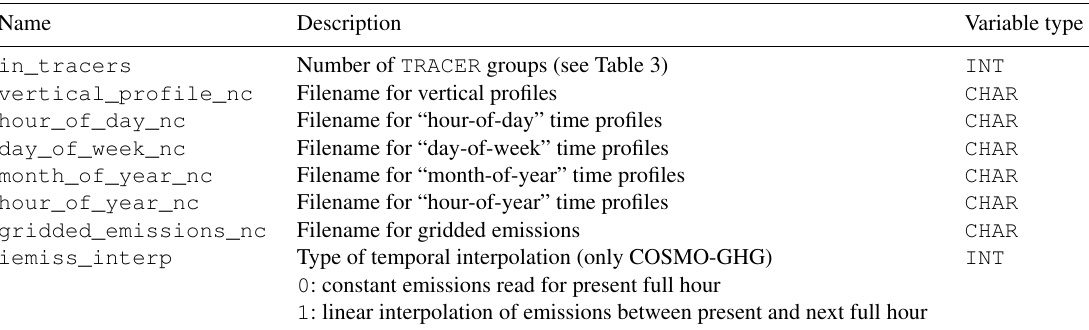
Table 2. Members of the GHGCTL and OAECTL namelist group required in INPUT_GHG for COSMO-GHG and INPUT_OAE for COSMO- ART, respectively, for setting up the online emission